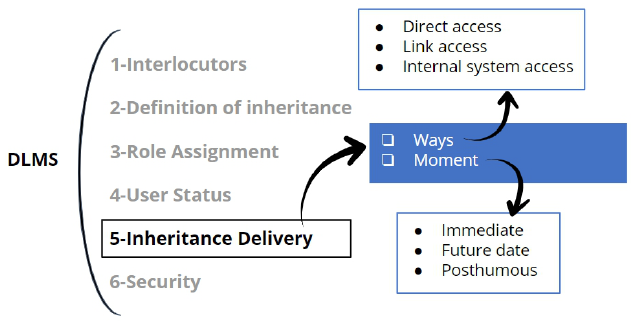
Fig. 4. Role Assignment in DiLeMa Framework.